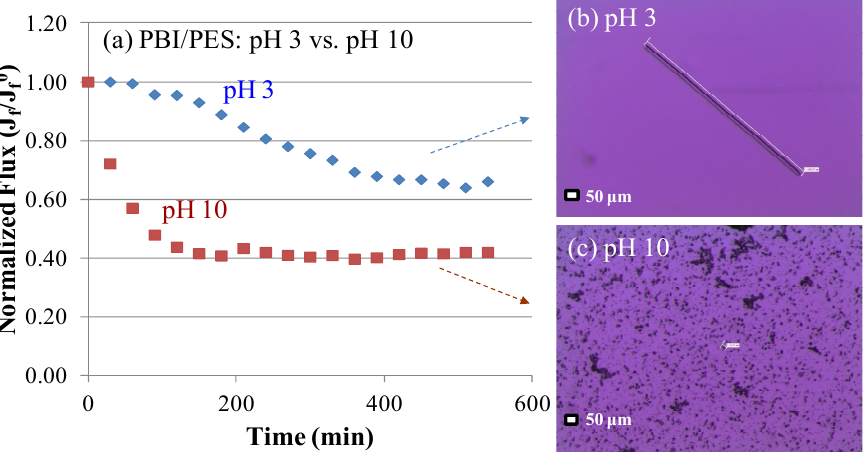
Figure 8. Comparison of gypsum scaling on the PBI/PES membrane at pH 3 and 10 under the FO mode. ( a ) Water flux vs . time at pH 3 and pH 10; ( b ) a microscopic image of gypsum crystals formed at pH 3 and ( c ) pH 10. (The scaling solution contained 70 mM CaCl SO and 38 mM NaCl, with a gypsum saturation index of 3.1, with 40 mM Na 2 4 a cross-flow velocity of 23 cm/s ( Re = 2496) at 24 ± 1 °C. The draw solution was 1.85 M MgCl 2